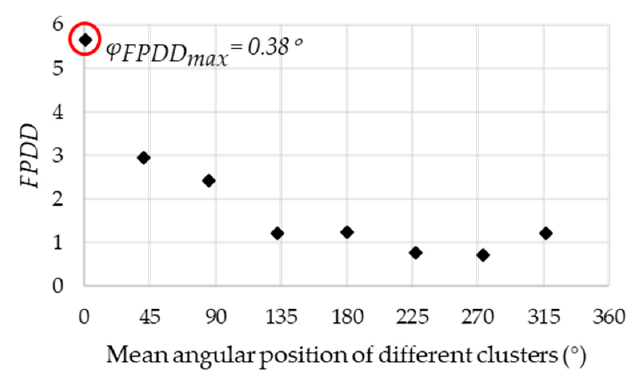
Figure 7. Calculated FPDD s for eight feature-point clusters.